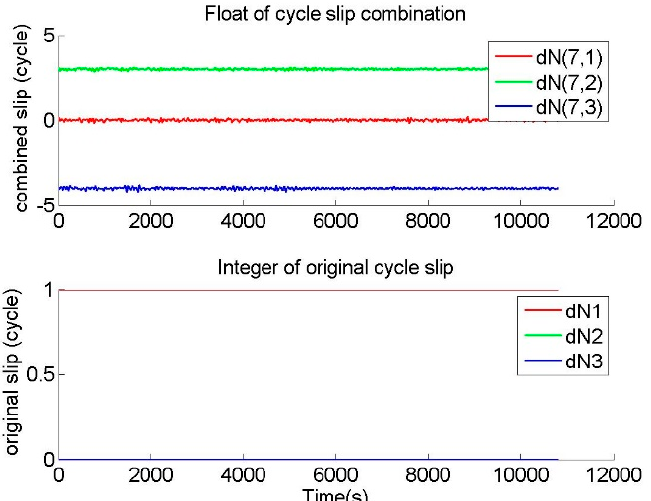
Figure 8. Repair results of the cycle slip combinations and original cycle slips from GTCSR, where the phase data had the known cycle slips of (1,0,0) epoch by epoch on GPS satellite 10 at CUT0 station during the geomagnetic storm that started from UTC 2016/05/08 00:00:00.